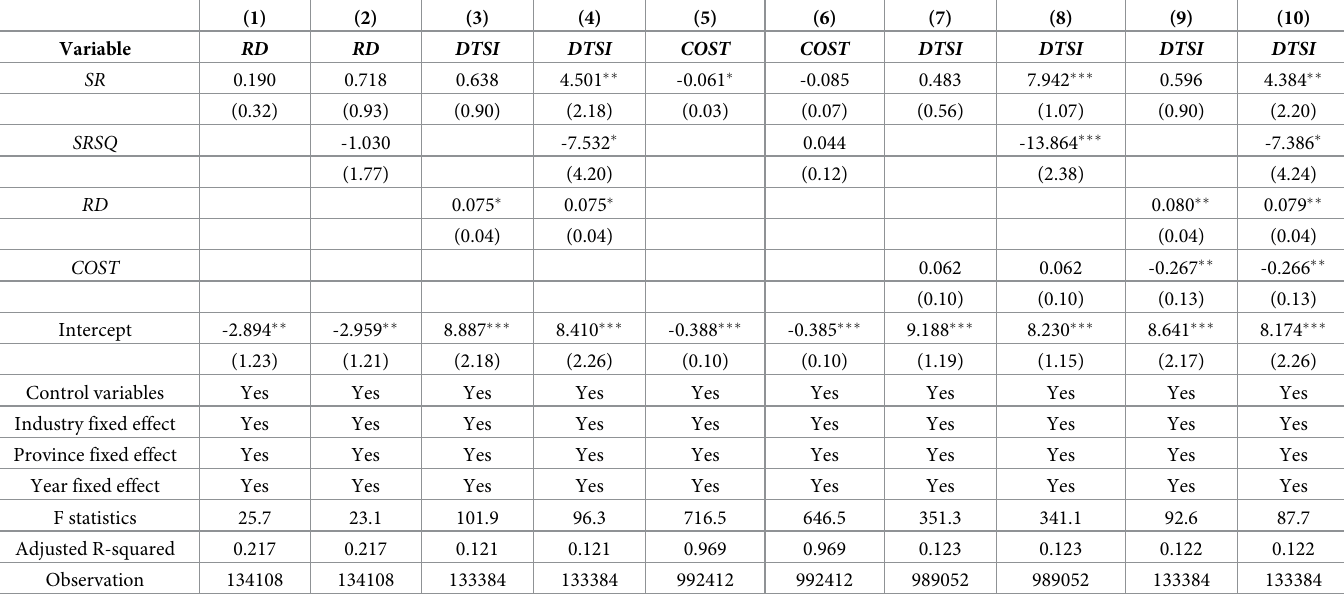
Table 4. The results of mediation